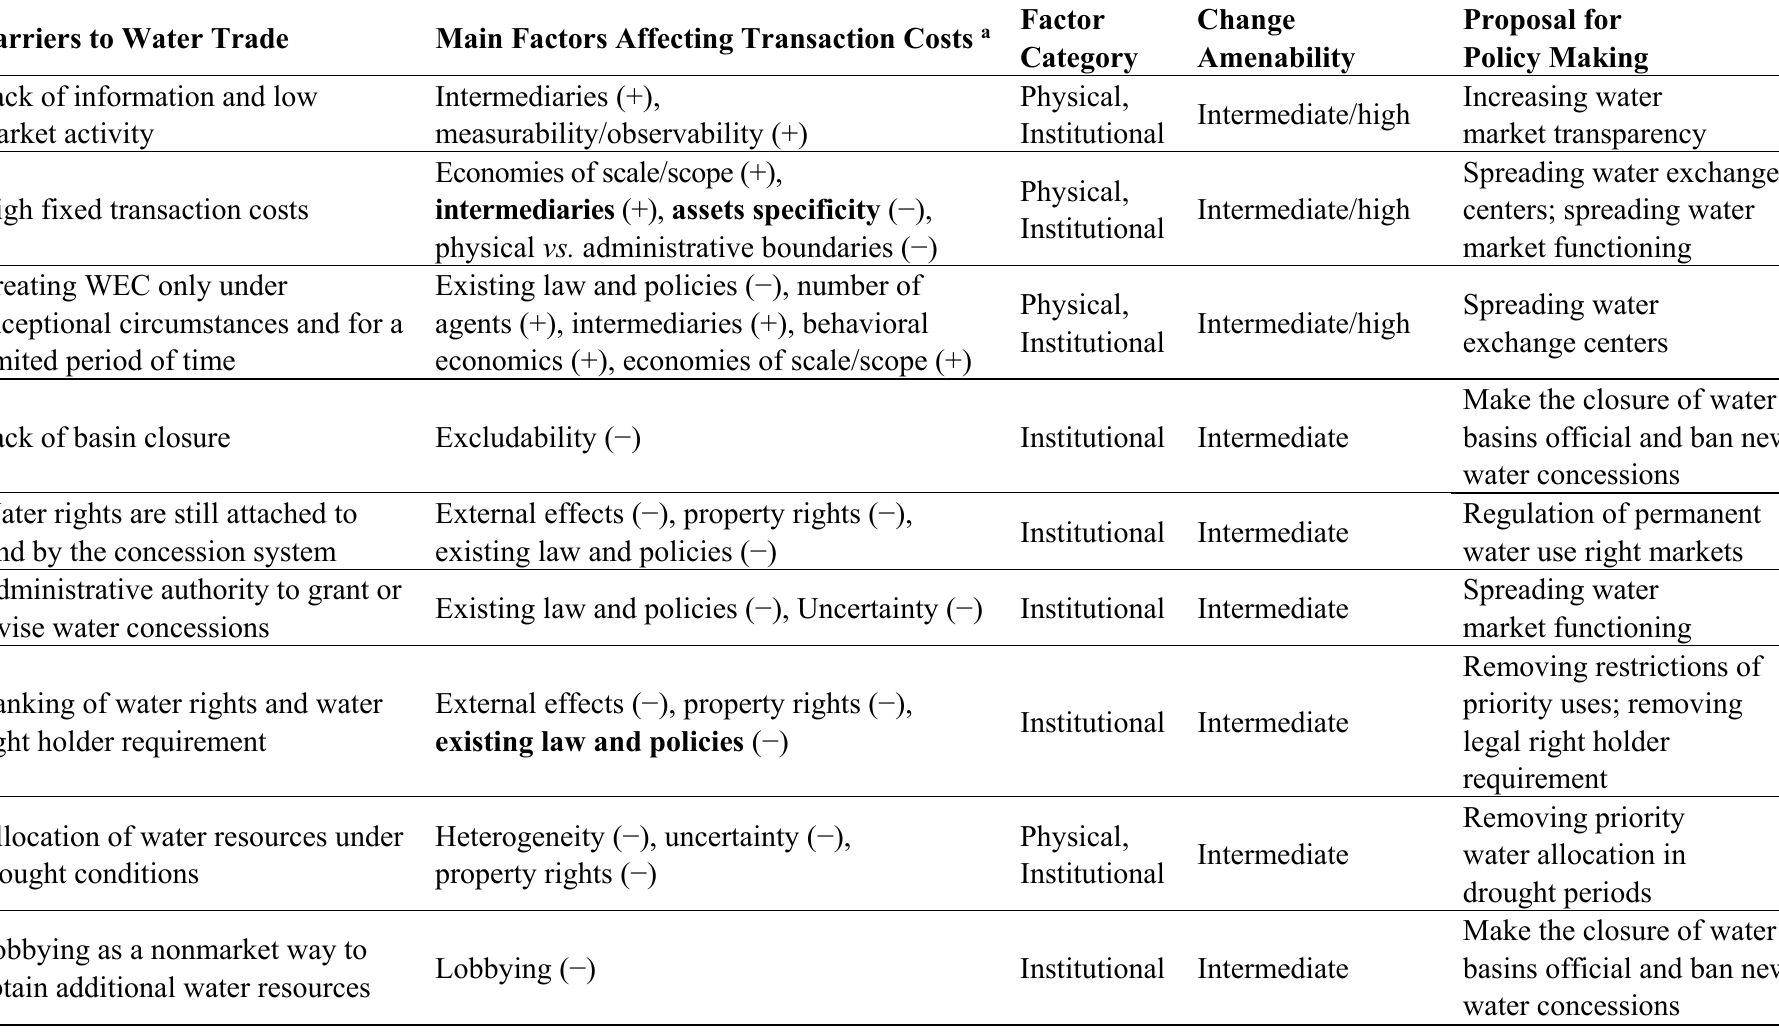
Table 3. Relationship among physical and institutional factors affecting transaction costs, barriers to water trade and design proposals. WEC, Water exchange